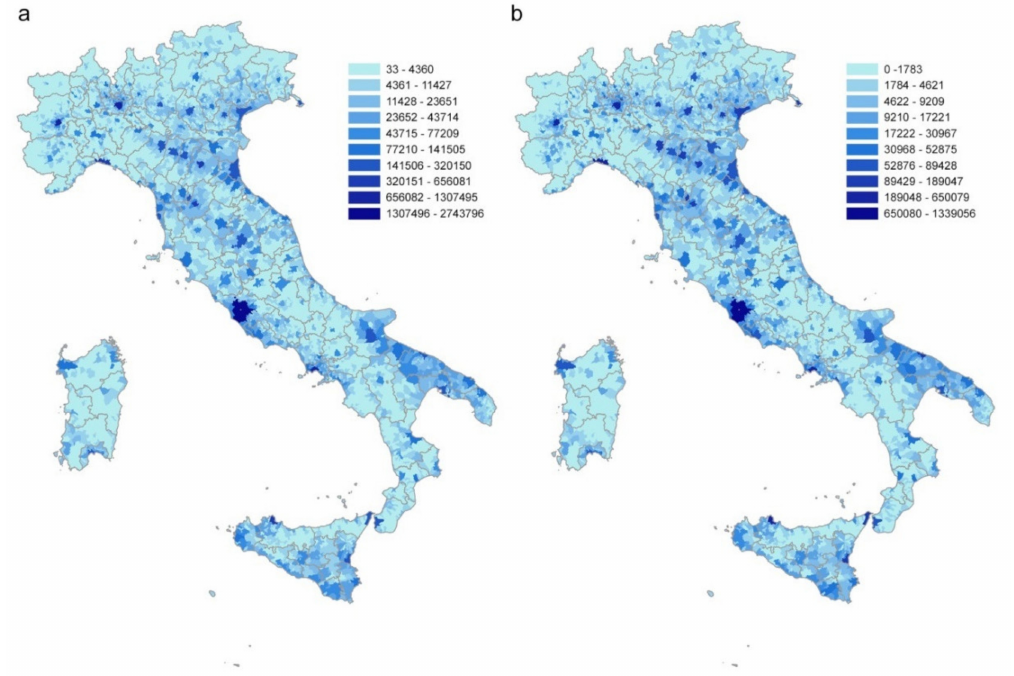
Figure 1. Distribution of ( a ) the Italian population and ( b ) daily commuters at the municipality level. Source ISTAT.